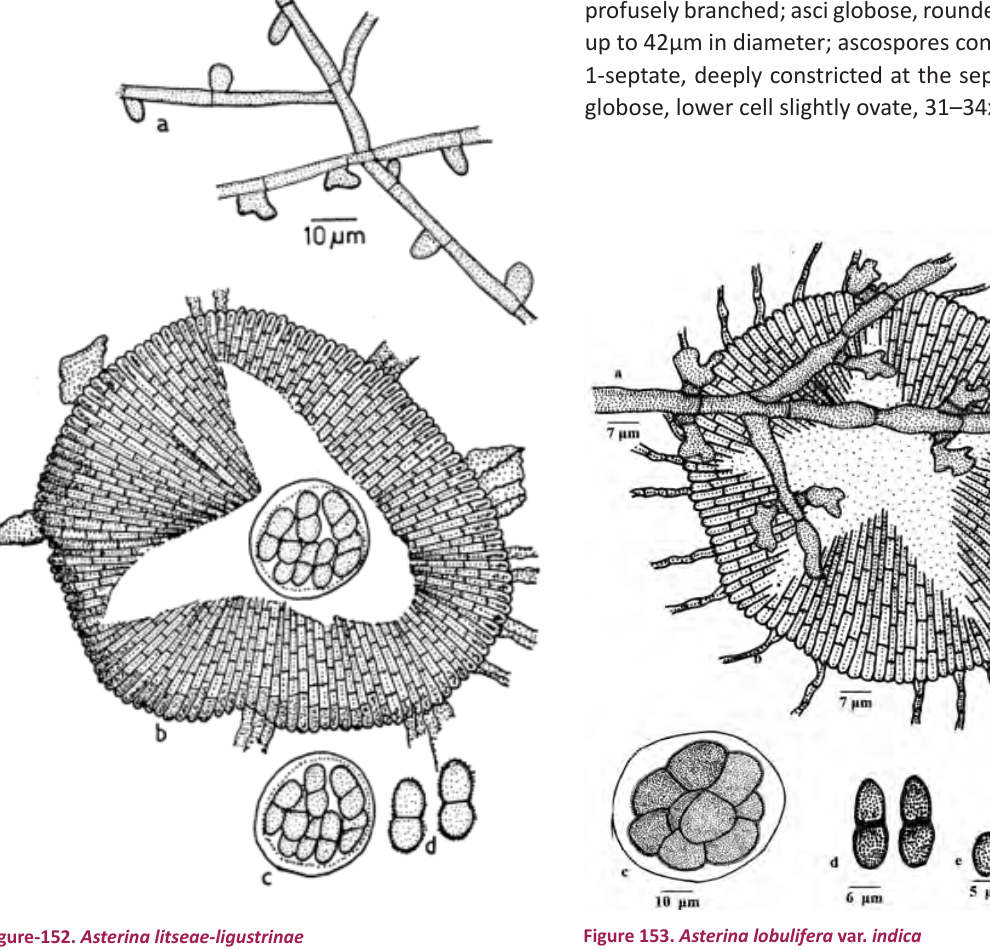
Figure-152. Asterina litseae-ligustrinae a - Appressorium; b - Thyriothecium; c - Ascus; d - Ascospores